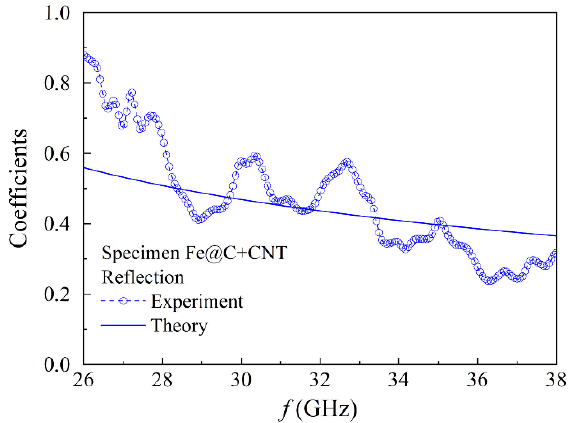
Figure 8. Frequency dependence of the reflection coefficient in the millimeter waveband for the nanocomposite sample of 10 mm in thick with Fe@C particles and CNT.